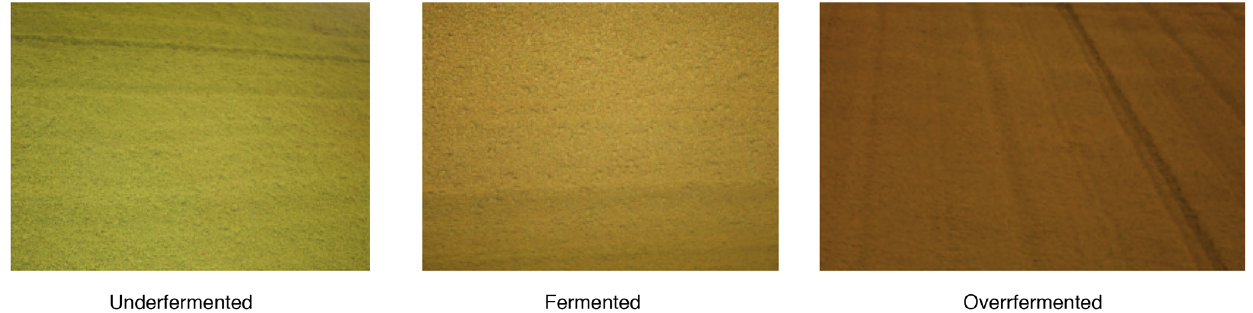
Figure 3. The categories of tea images captured in the Sisibo Tea Factory, Kenya, during black tea